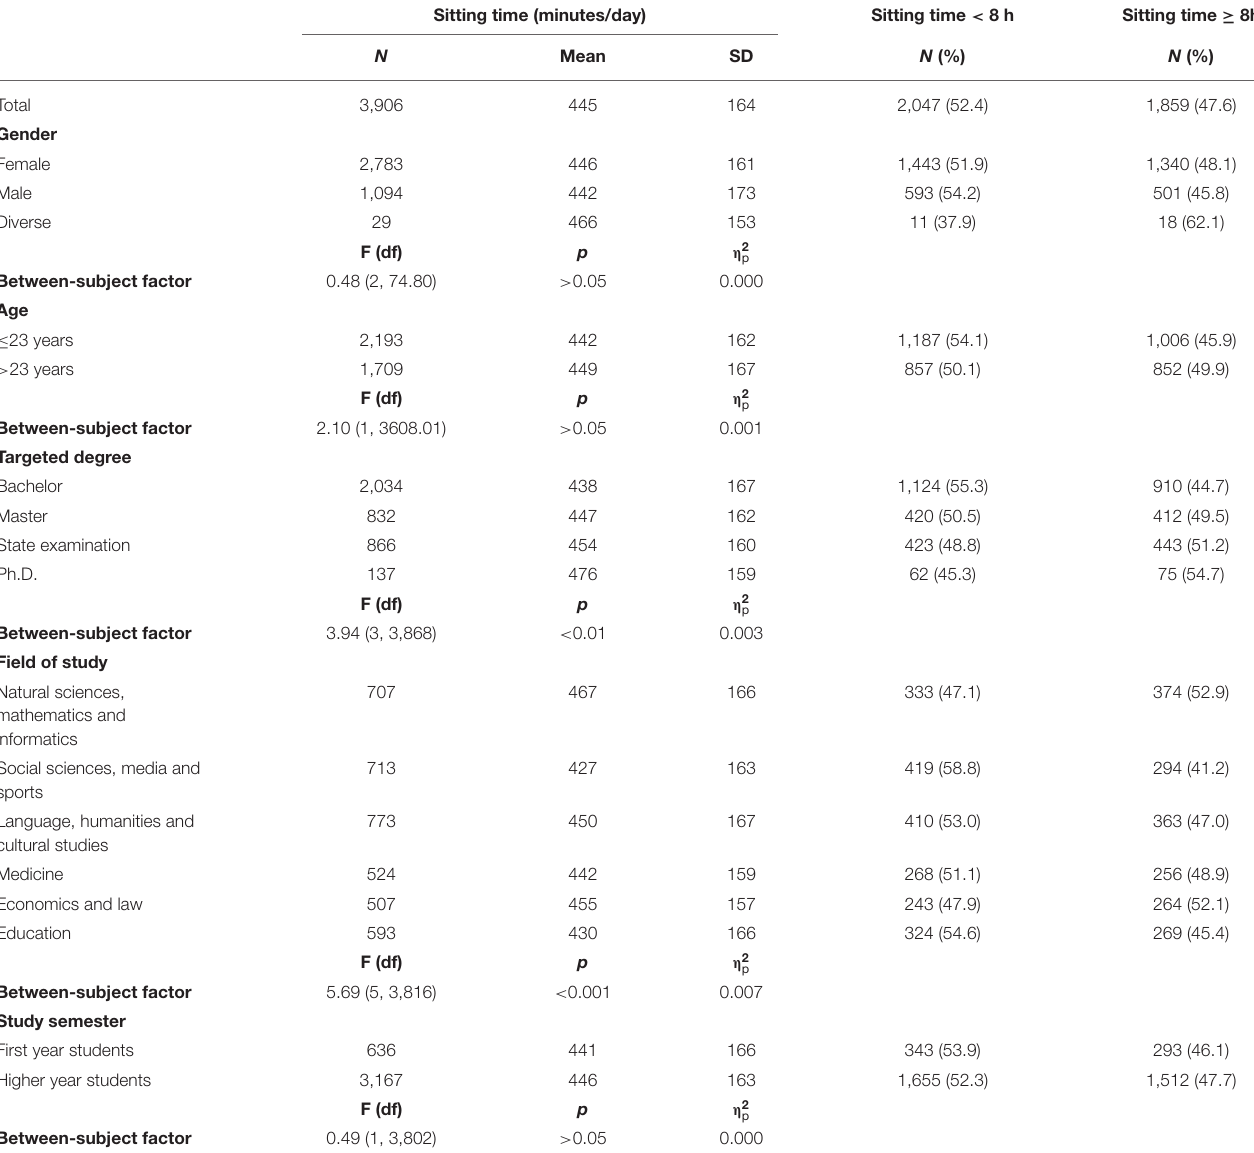
TABLE 4 | Means, standard deviations, and analysis of variance in